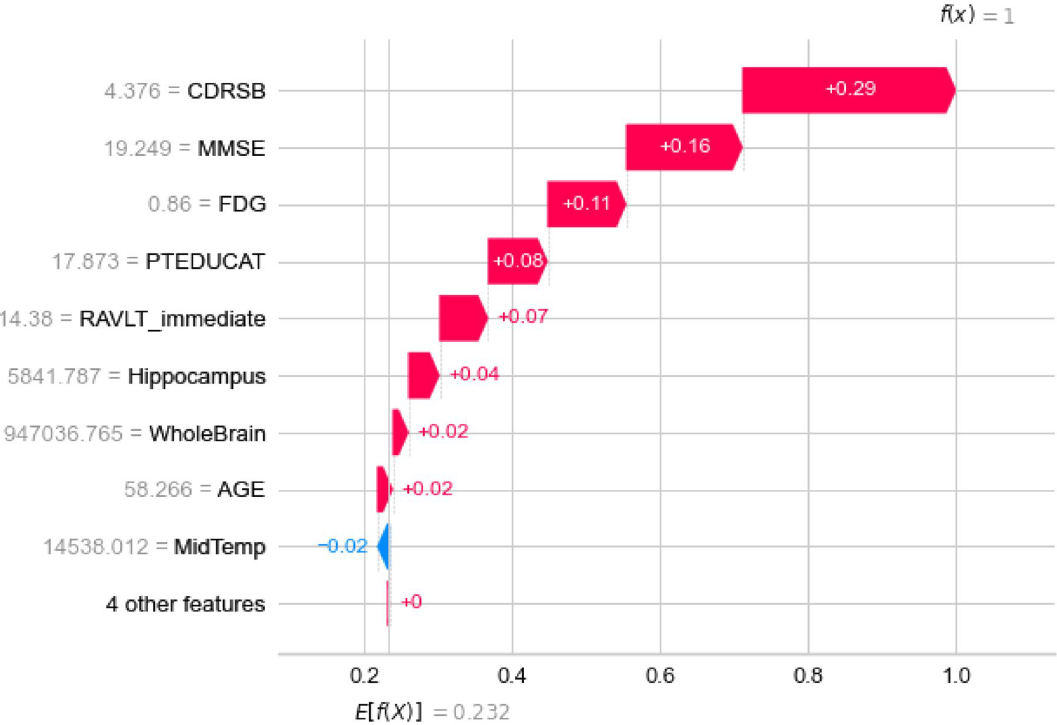
Figure 18. Features influence on a subject with AD diagnosis to be predicted as AD.